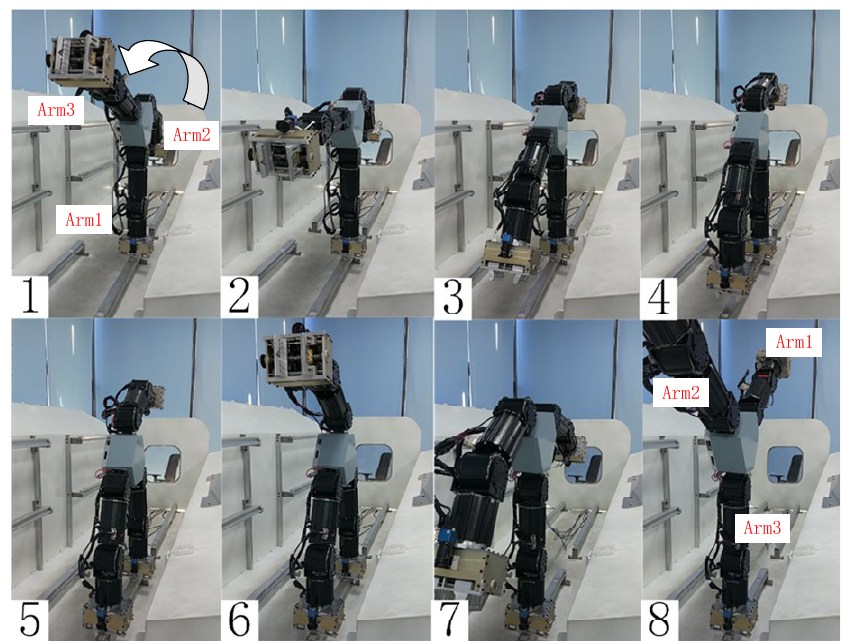
Figure 13. Rolling mode. In this mode, arm 1 grips the handrail, arm 2 rises, the center of gravity of the robot is adjusted, and then arm 3 drops and grasps the handrail. Finally, arm 1 rises to complete a tumbling motion. The three arms alternately run to achieve continuous rolling of the robot.